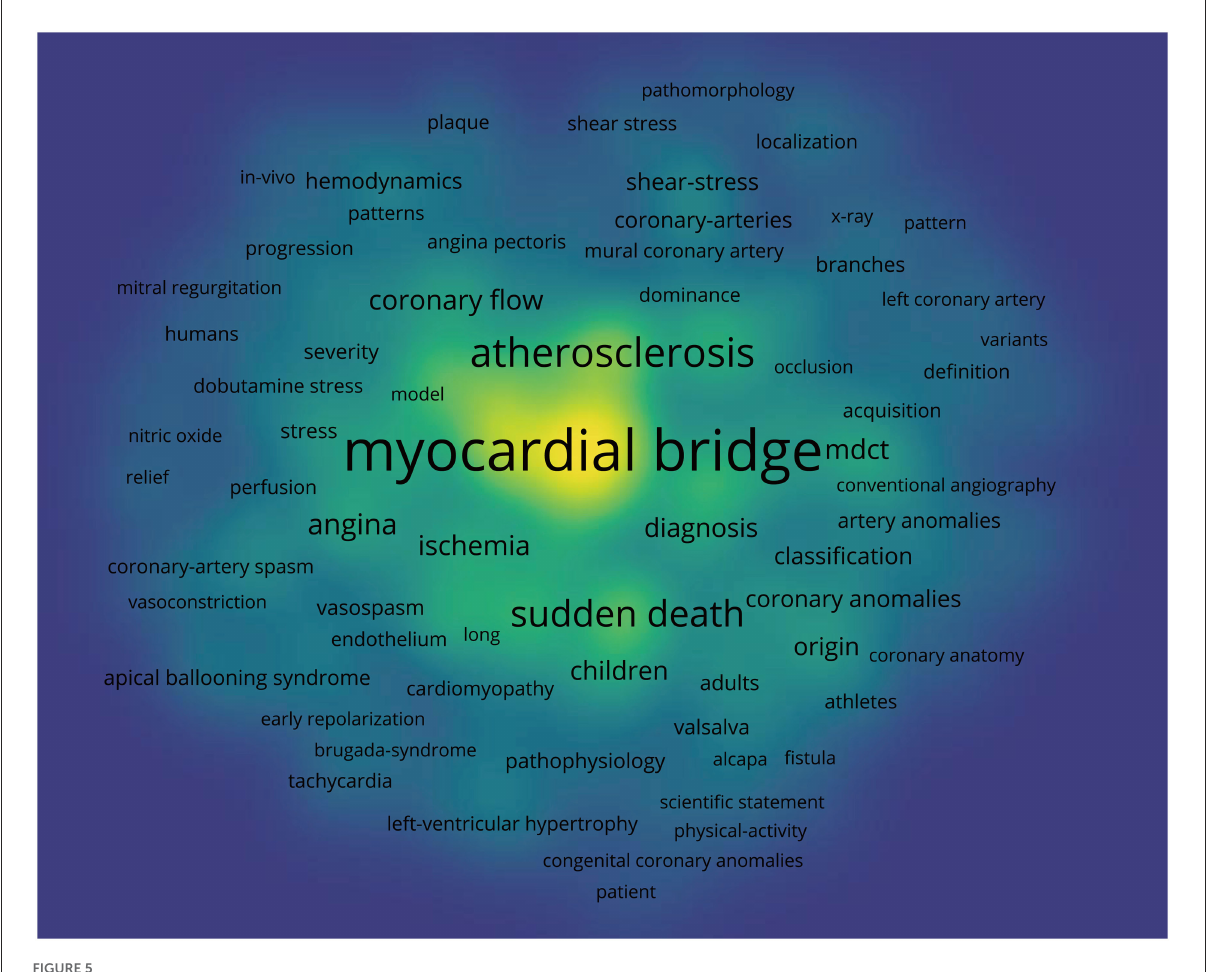
FIGURE5 Keywords density visualization of the myocardial